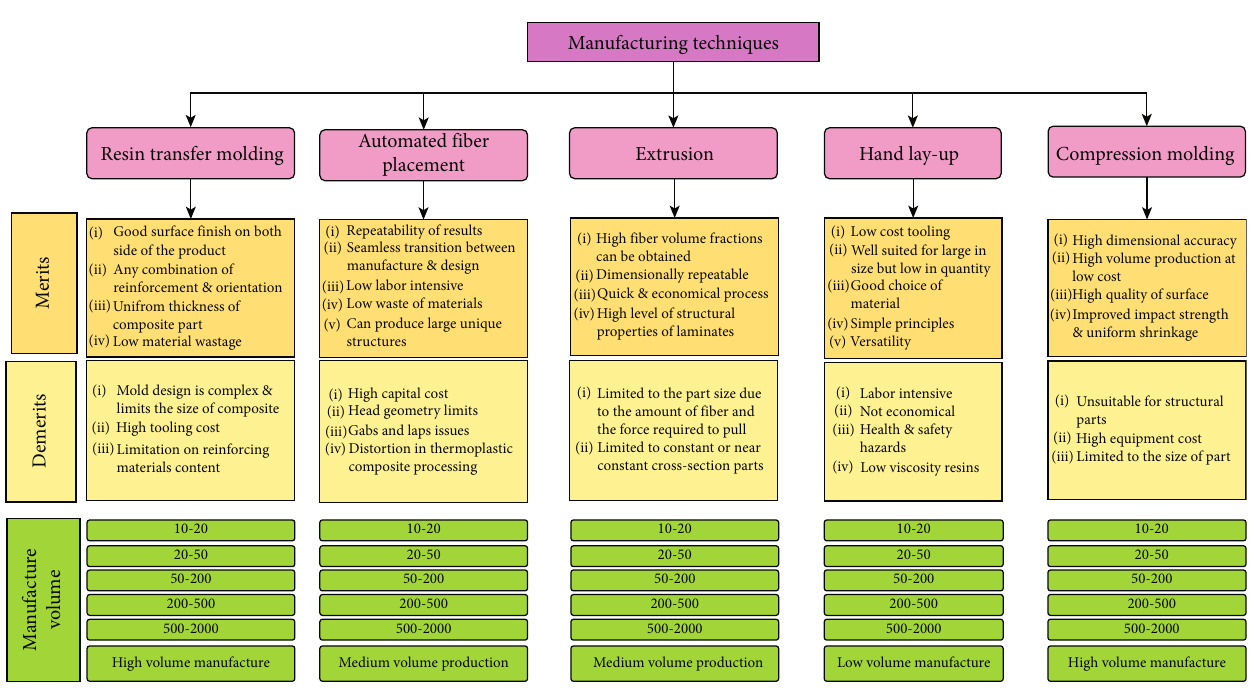
Figure 1: Manufacturing techniques of polymer composites. Table 1: Properties of hemp fi ber.